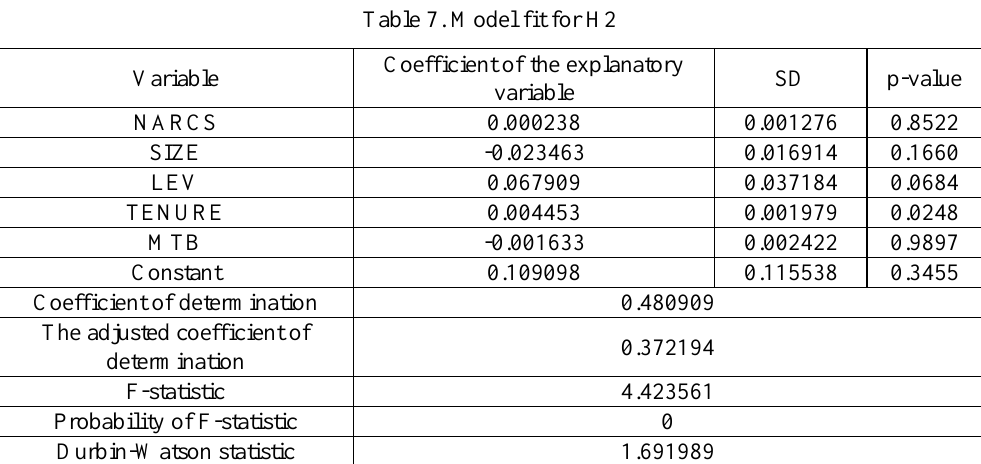
Table 7. Model fit for H2